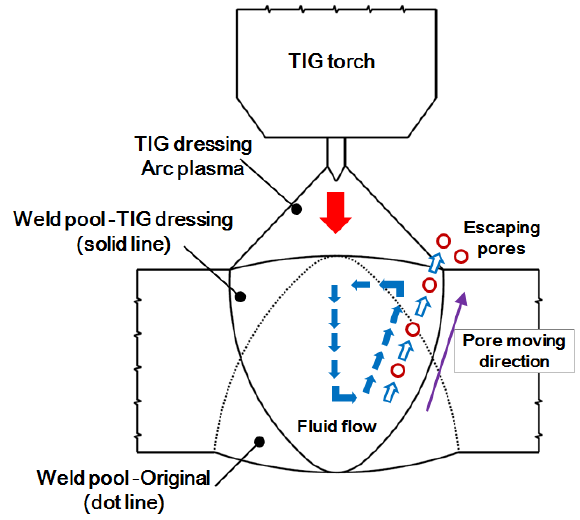
Figure 14. Schematic diagram of porosity escape.